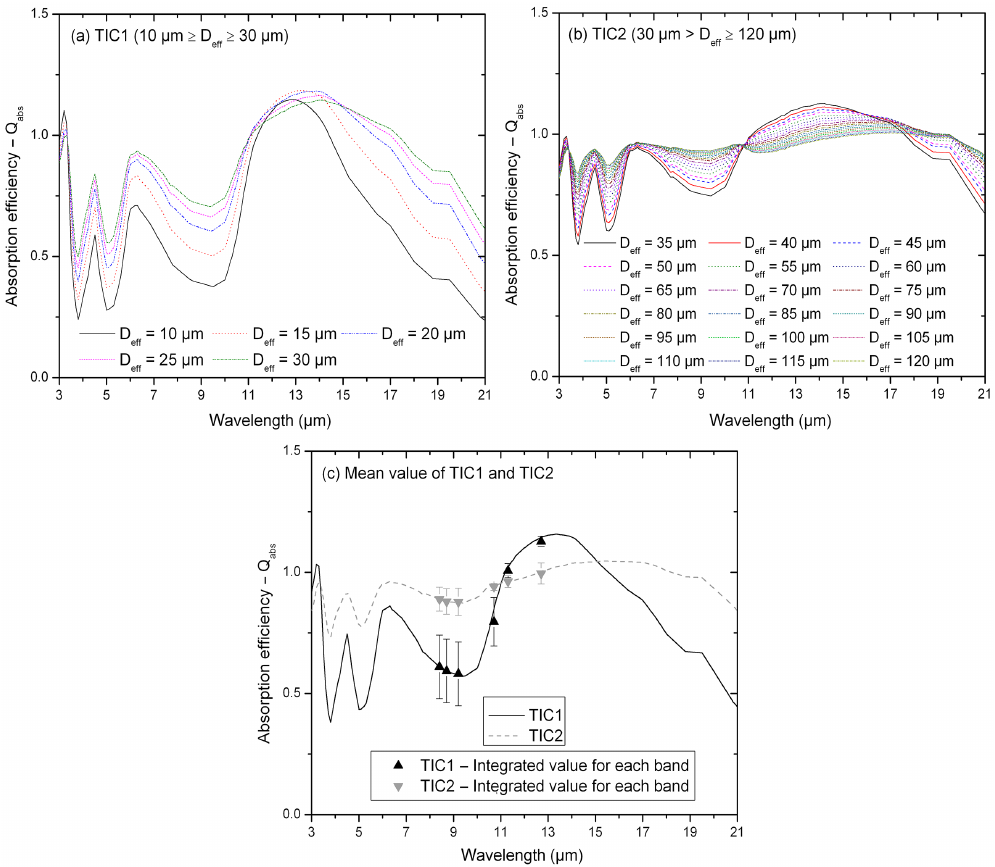
Figure 2. (a, b) Absorption efficiency spectra for TIC1 and TIC2 particles across a range of D eff values. (c) Mean absorption efficiency and standard deviations across the spectra of (a) and (b) . The triangular symbols represent the integration of the absorption efficiency across the six bands of the CIMEL CE-312. These efficiencies were derived for the “severely roughened solid column”-type crystals of Yang et al. (2013) and Baum et al. (2014), available at